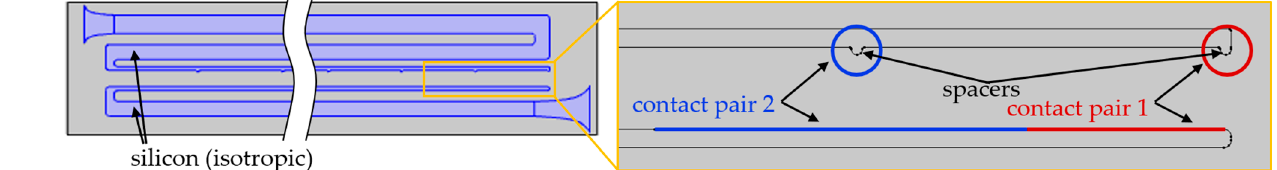
Figure 4. Simulation setup of a single actuator by COMSOL Multiphysics: a voltage is systematically increased between the electrodes, and the spacers defined as contact pairs allow a steady simulation.